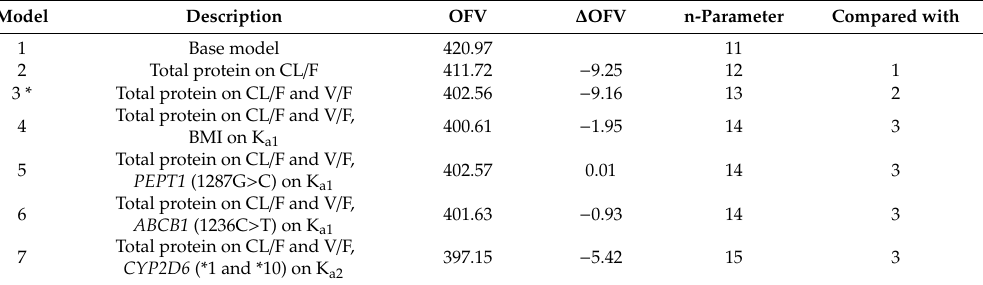
Table 5. Stepwise search for covariates.